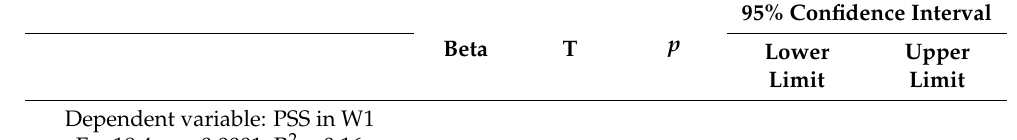
Table 6. Predictors of students’ stress perception (stepwise regression analyses).